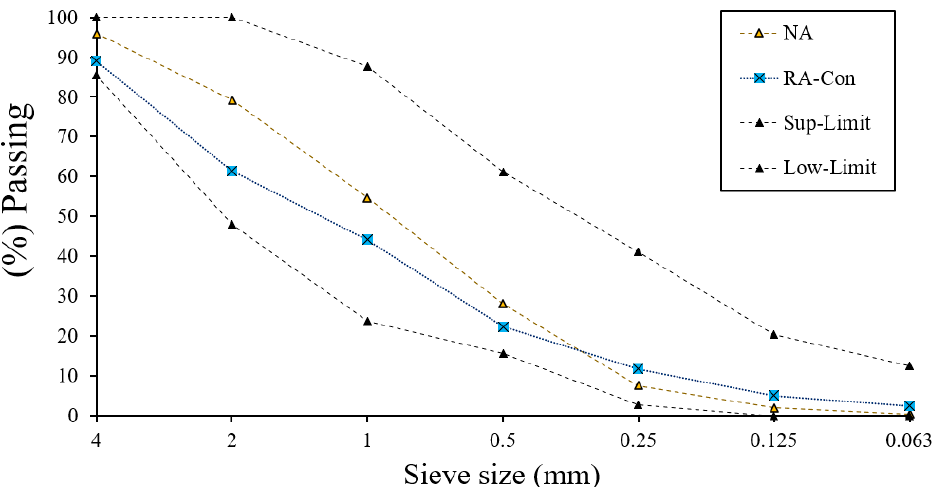
Figure 2. Recycled aggregate size distribution curve compared to the limits of NBE FL-90 [56] adapted to sieve size established by UNE-EN-933-2 [55].